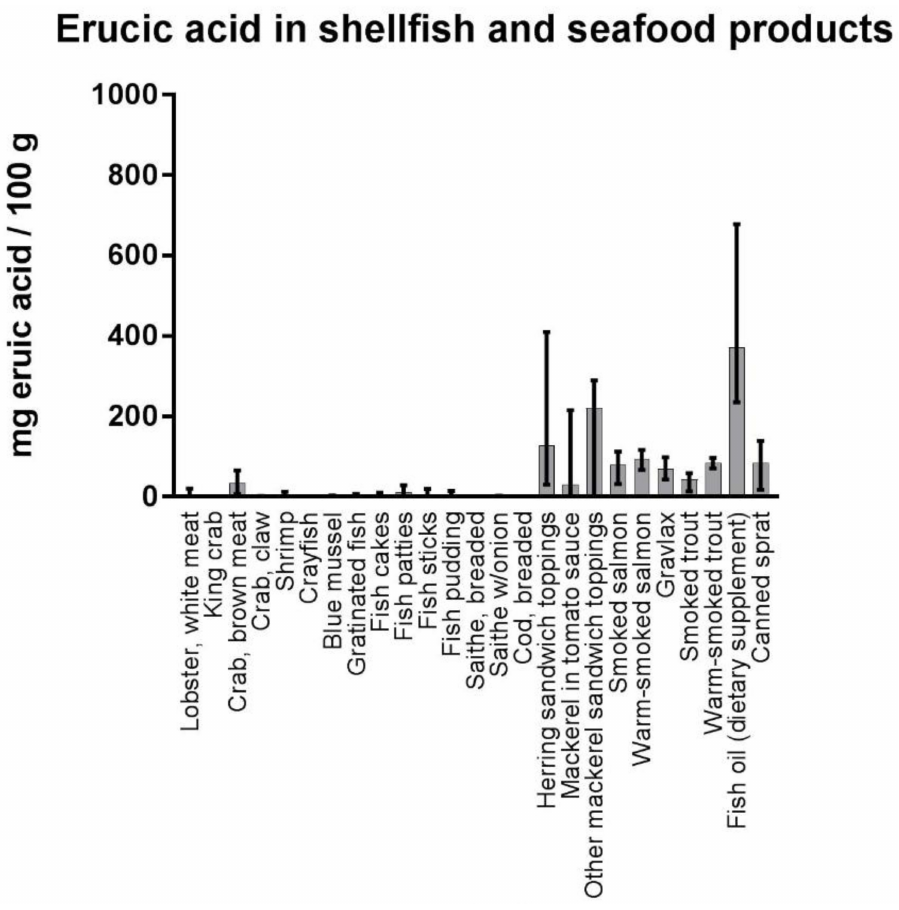
Figure 6. Content of erucic acid (mg fatty acid/100 g sample) in processed seafood products sampled in Norway. The bars show the mean value of erucic acid, as well as the minimum and maximum values. The number of samples for each category were as follows; lobster, white meat n = 15, king crab n = 151, crab, brown meat n = 10, crab, claw n = 10, shrimp n = 11, crayfish n = 52, blue mussel n = 12, gratinated fish n = 5, fish cakes n = 5, fish patties n = 5, fish sticks n = 5, fish pudding n = 5, breaded saithe n = 2, saithe w/onion n = 5, breaded cod n = 3, herring sandwich toppings n = 44, mackerel in tomato sauce n = 11, other mackerel sandwich toppings n = 13, smoked salmon n = 18, warm-smoked salmon n = 3, gravlax n = 6, smoked trout n = 4, fish oil (dietary supplement) n = 17, canned sprat n =